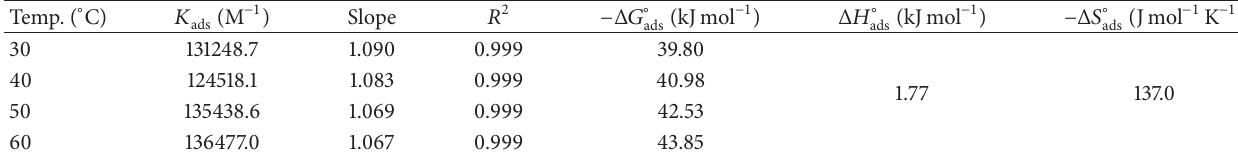
Table 4: Thermodynamic parameters for the adsorption of HIBH on mild steel surface in 1M HCl acid at different temperatures. Temp. ( ∘ C)